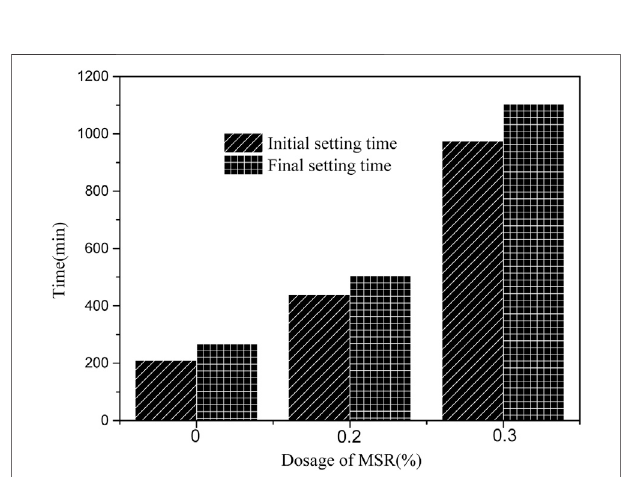
FIGURE 6 | Initial and fi nal setting time determined as per ASTM C191 with different dosage of MSR.